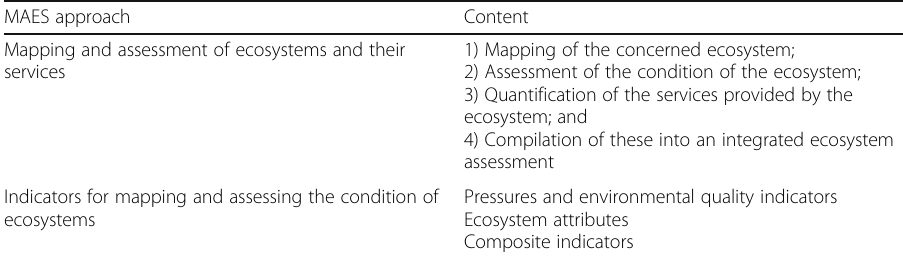
Table 6 Mapping and Assessment of Ecosystems, Their Services and the Condition of Ecosystems (European Union 2013; Maes et al.